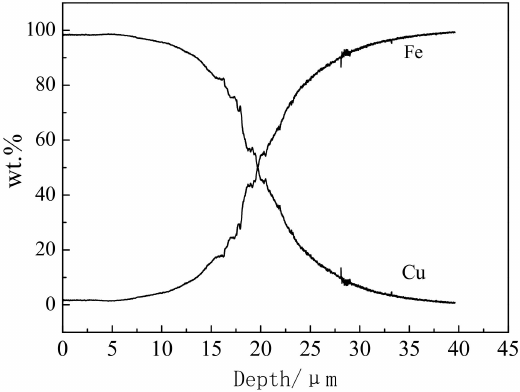
Figure 4. The content distribution of Cu in Cu − Fe after annealing diffusion treatment at 1050 ◦